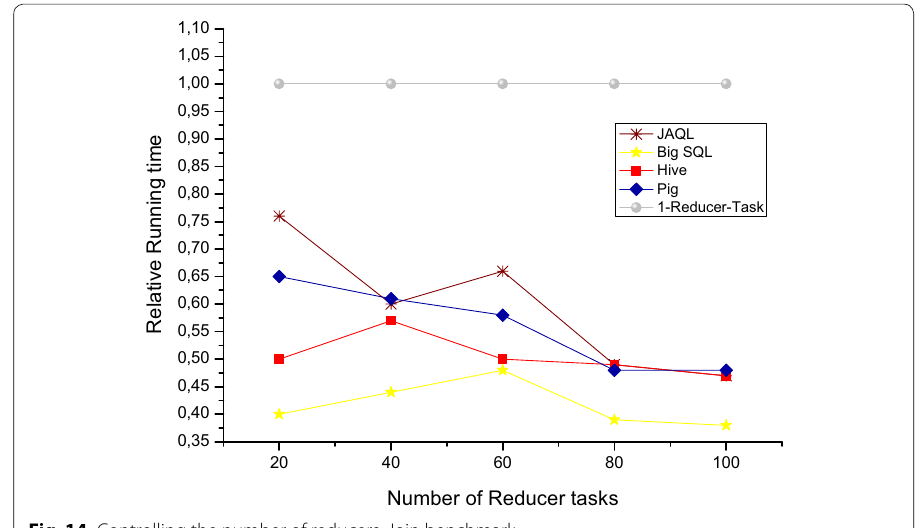
Fig. 14 Controlling the number of reducers: Join